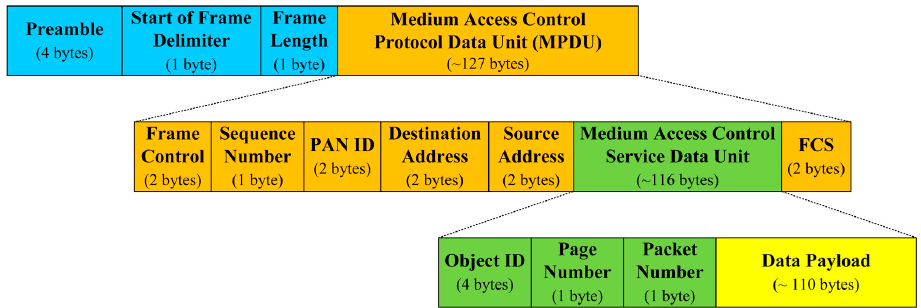
Figure 11. The format of IEEE 802.15.4 data frame.